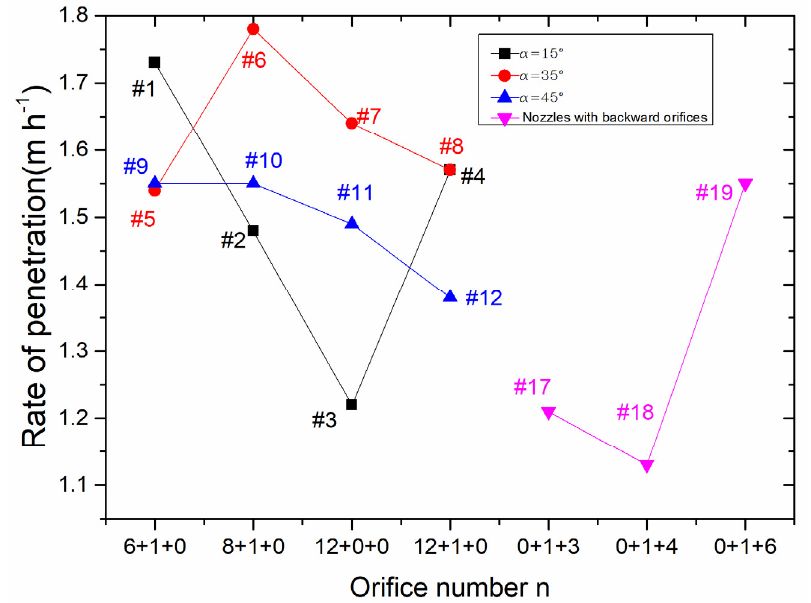
Figure 8. Average ROP vs. the orifice number of nozzles.